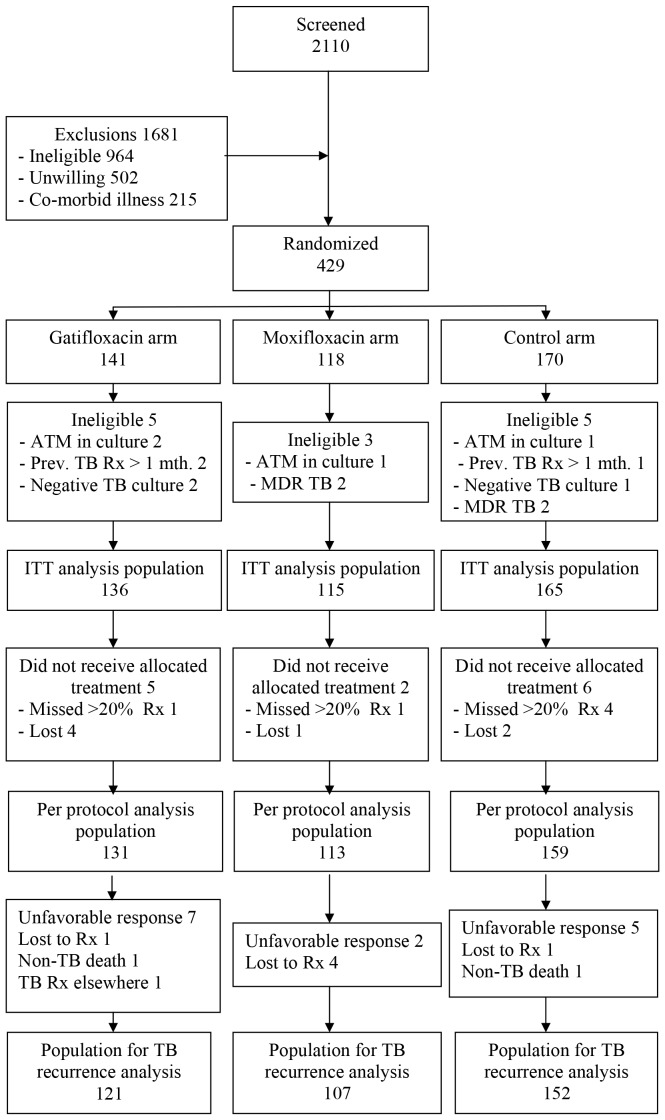
Flow diagram of patients from screening to analysis.